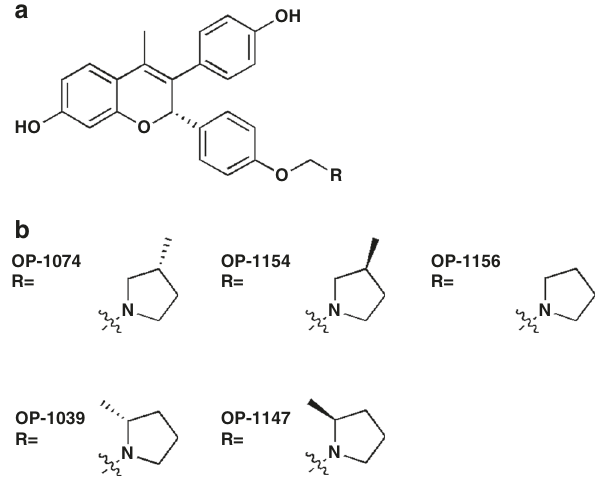
Fig. 1 Benzopyran-based estrogen receptor alpha inhibitors. Structure of benzopyrene scaffold ( a ) and side chain ( b ) of OP-1074 and